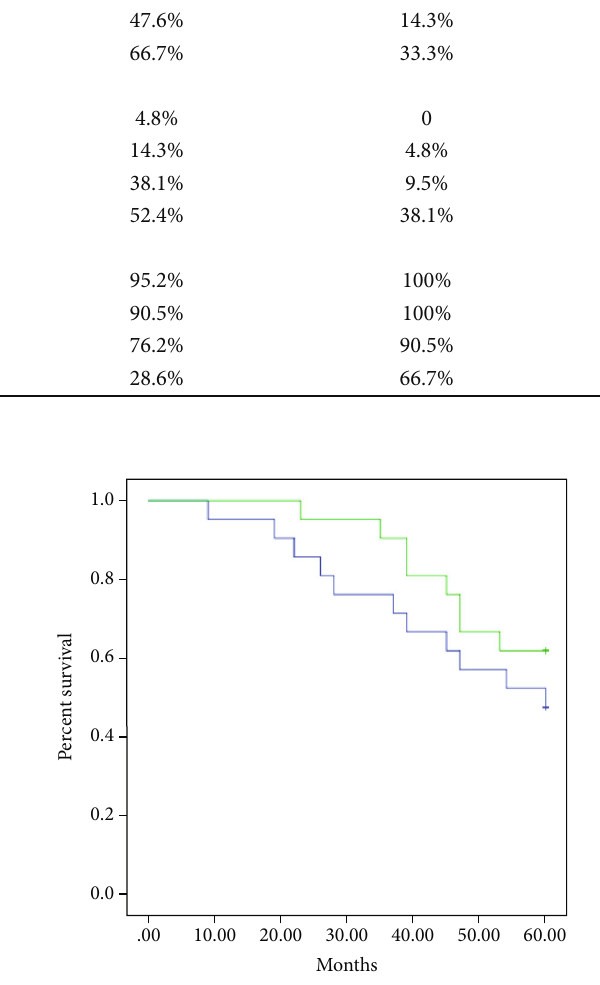
Figure 2: Kaplan-Meier survival curves depicting distant metastasis rate among high dose group ( Green line ) and low dose group ( blue line ). There is no di ff erence between the study group and the control group Log Rank =1.120P